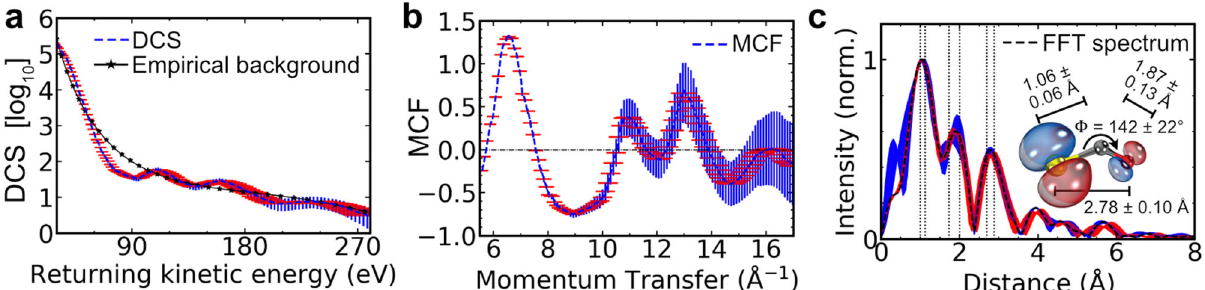
Fig. 4 FT-LIED retrieval of OCS + structure. a Differential cross-section (DCS; blue dashed line) as a function of returning kinetic energy corresponding to electrons detected in coincidence with OCS + . A linear regression fi lter (black starred line) is applied to the DCS to extract the incoherent sum of atomic scatterings, I A . The area of uncertainty is given by the longitudinal detected momentum error (red horizontal) and the statistical error based on a Poissonian distribution (blue vertical). b The molecular contrast factor (MCF), de fi ned by I M / I A , as a function of momentum transfer. c Radial distribution (black dashed line) obtained by the Fourier transform (FT) of the MCF distribution shown in ( b ). The resulting FT spectrum contains three clear peaks corresponding to the C – O, C – S and O – S internuclear distances. The uncertainty in the measured peaks is indicated by the black dotted vertical lines (see supplementary note 2). A schematic of the retrieved asymmetrically stretched and bent OCS + structure is shown in the to a signi fi cantly bent and asymmetrically stretched OCS + structure, as shown in the lower right corner of Fig. 3b, which is drastically different from the equilibrium neutral ground state of OCS. Moreover, the corresponding theoretical ZCPs for equilibrium neutral ground state of OCS appear at four momentum points (grey vertical solid lines; 5.30, 6.03, 6.47, 6.84 a.u.) that are in poor agreement with the measured ZCPs (magenta vertical solid lines; 5.18, 5.84, 6.36, 7.00 a.u.).